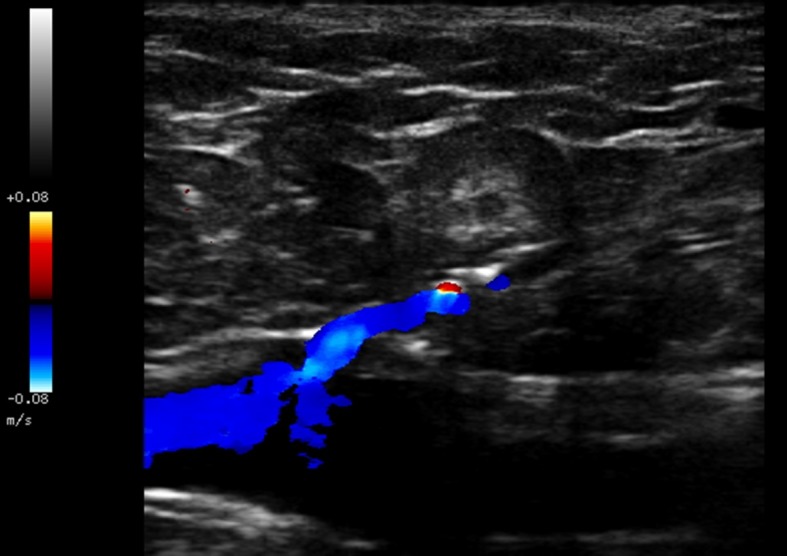
Control scan of saphenopopliteal junction immediately after thermoablation.